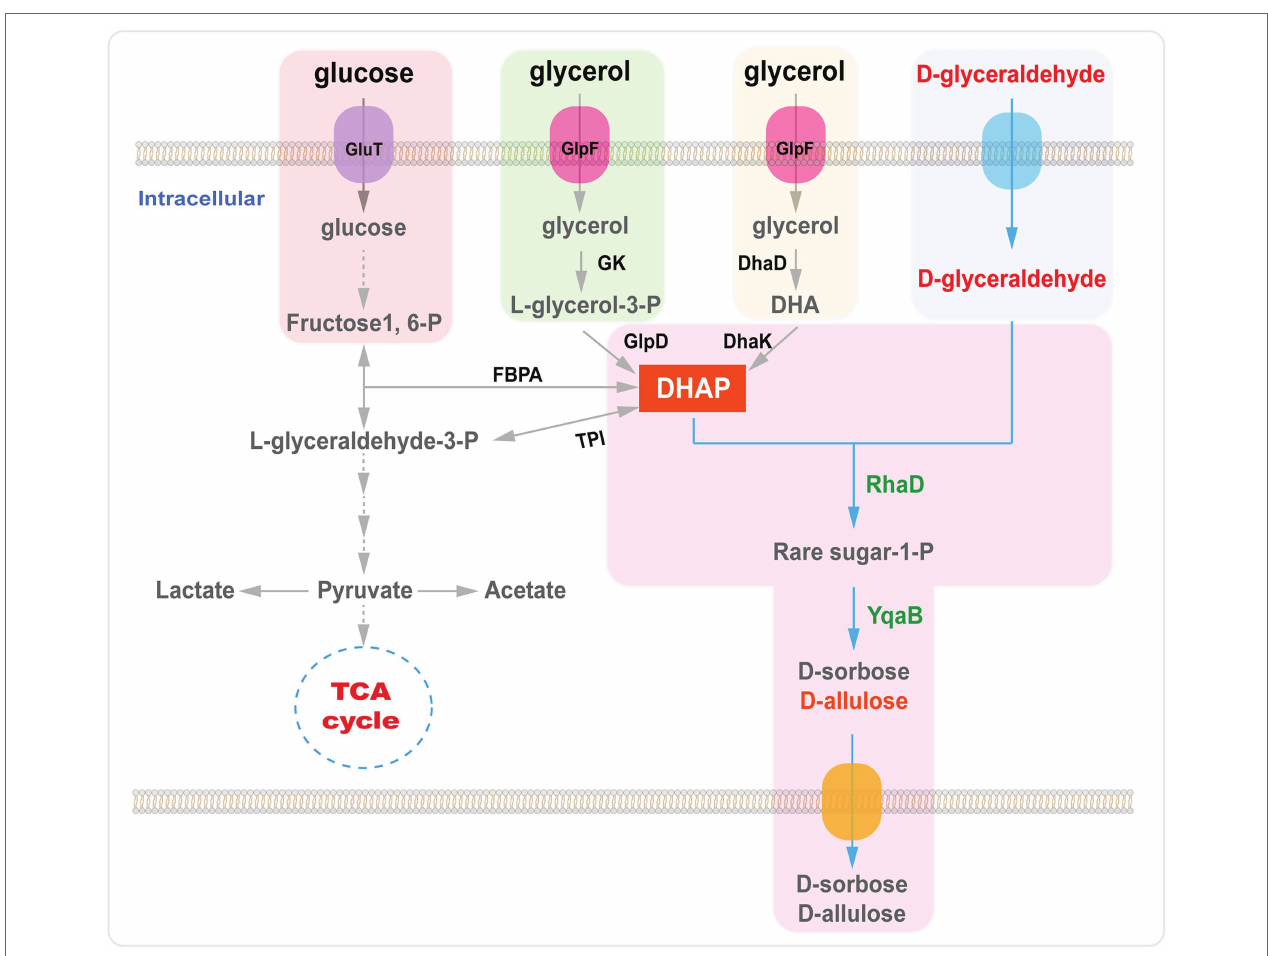
FIGURE 6 | Biosynthesis of D-allulose using RhaD aldolase from glycerol or glucose. GlpF, glycerol transporter; GK, glycerol kinase; GlpD, glycerol 3-phosphate dehydrogenase; DhaD, glycerol dehydrogenase; DhaK, dihydroxyacetone kinases; FBPA, fructose 1, 6-diphosphate aldolase; TPI, triose phosphate isomerase; RhaD, L-rhamnulose-1-phosphate aldolase; YqaB,